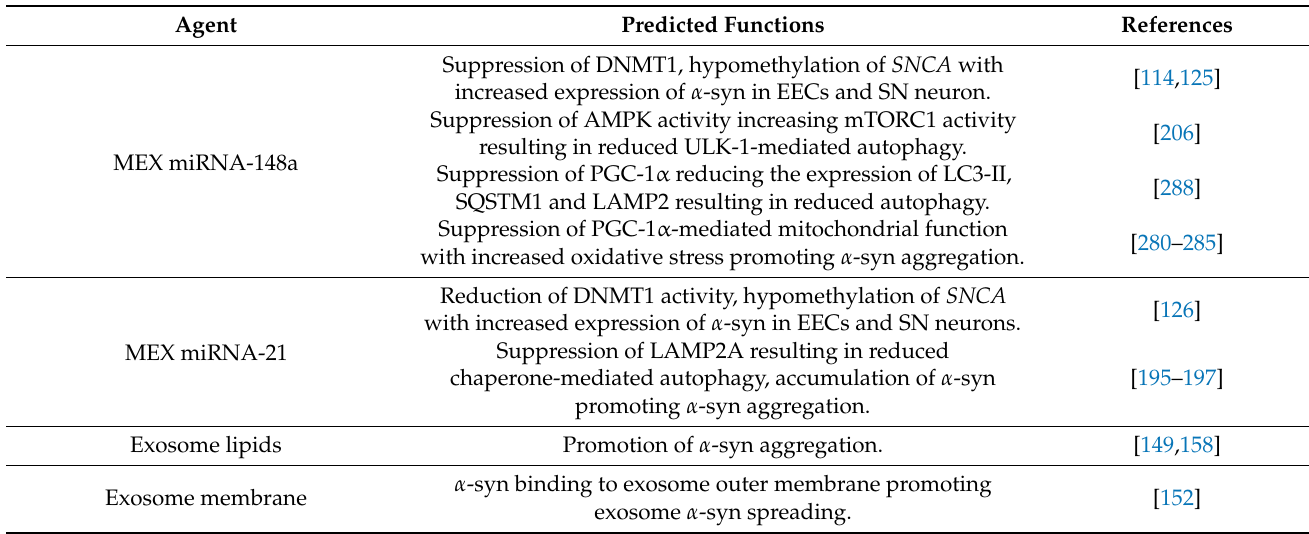
Table 2. The potential impact of milk-derived exosomes (MEX) on α -synuclein pathology.